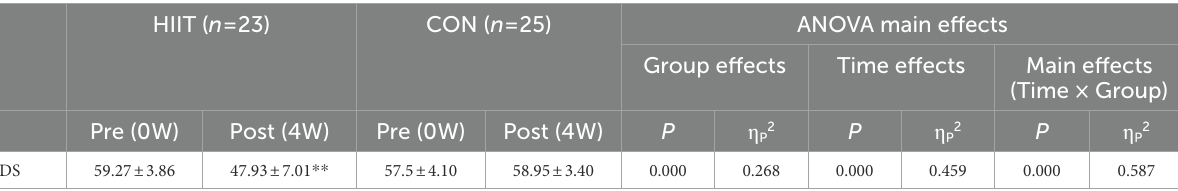
TABLE 5 Psychological well-being before and after the four-week study program.